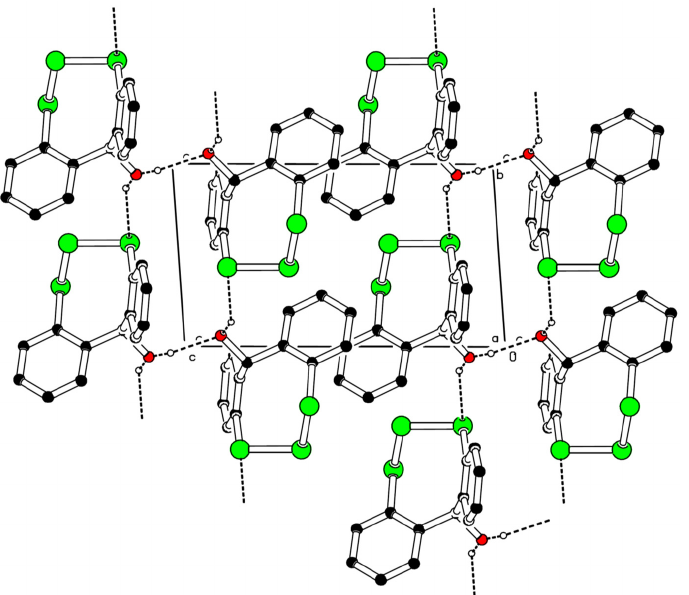
Figure 3. Partial packing diagram of the title compound 5 . Intermolecular hydrogen bonds are indicated as dashed lines.